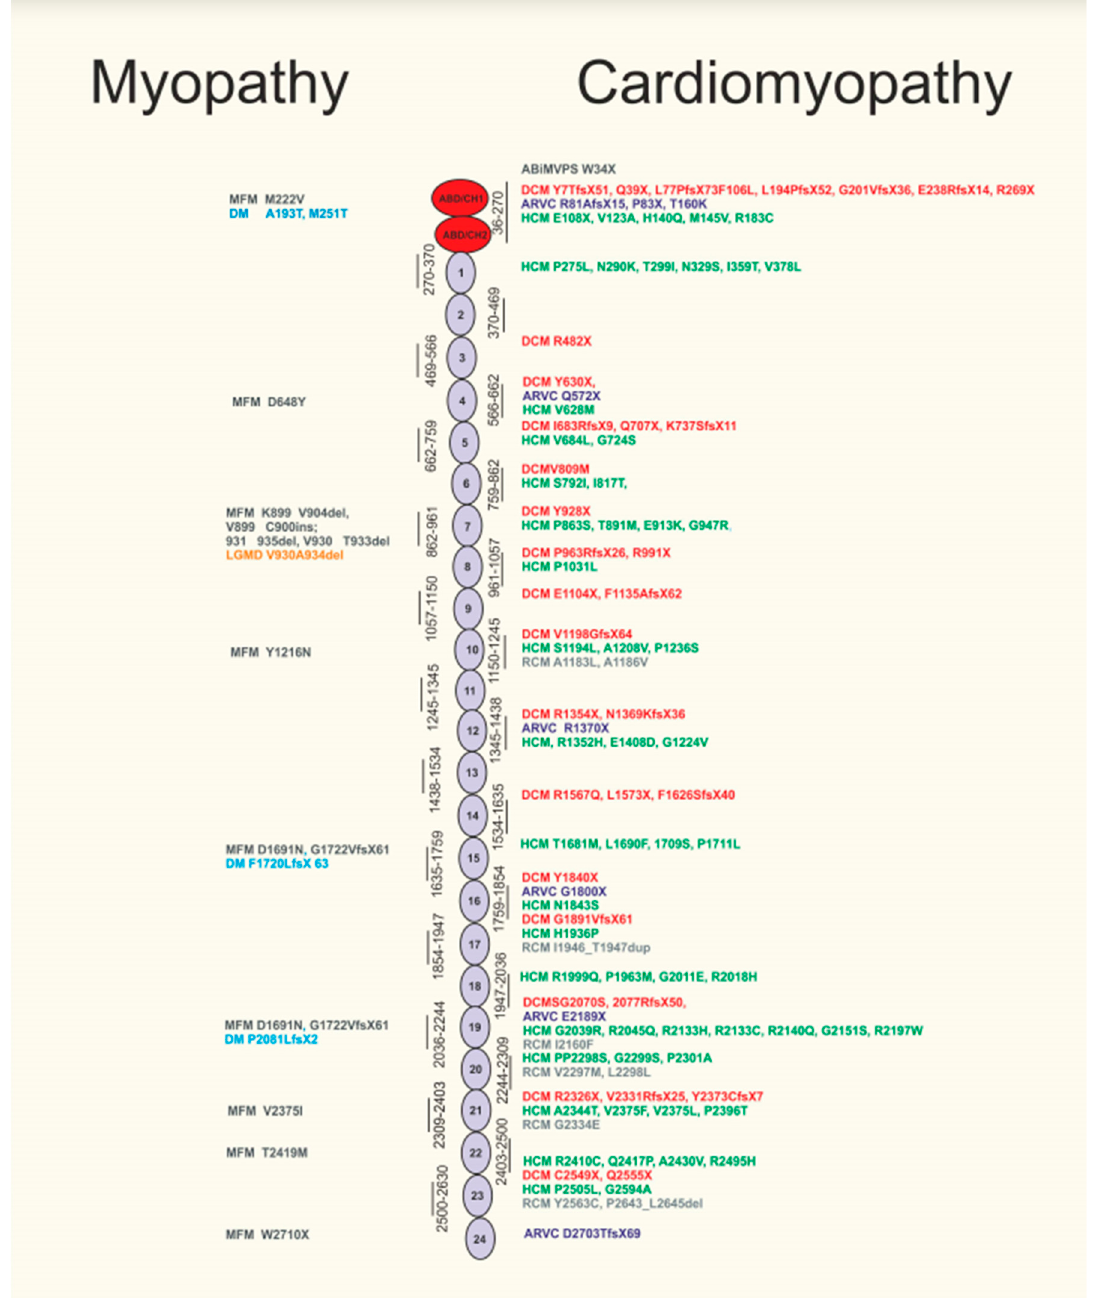
Figure 2. Summary of FLNC sequence variants in relation to disease phenotypes.